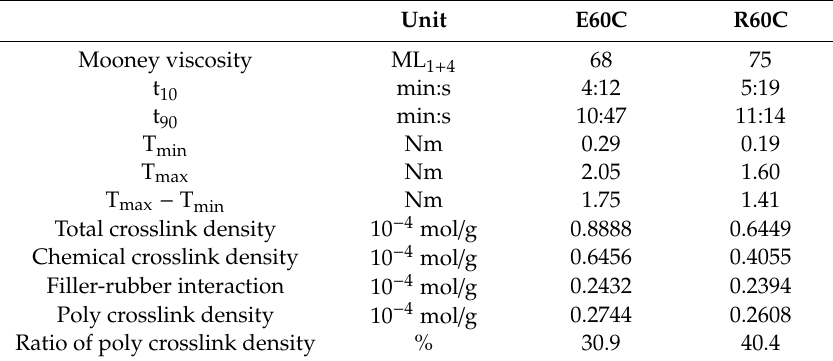
Figure 7. Crosslink densities of vulcanizates of emulsion styrene butadiene rubber (ESBR) and reversible addition-fragmentation radical transfer (RAFT) ESBR carbon black-filled compounds. Table 6. Cure characteristics and crosslink densities of emulsion styrene butadiene rubber (ESBR) and reversible addition-fragmentation radical transfer (RAFT) ESBR carbon black-filled